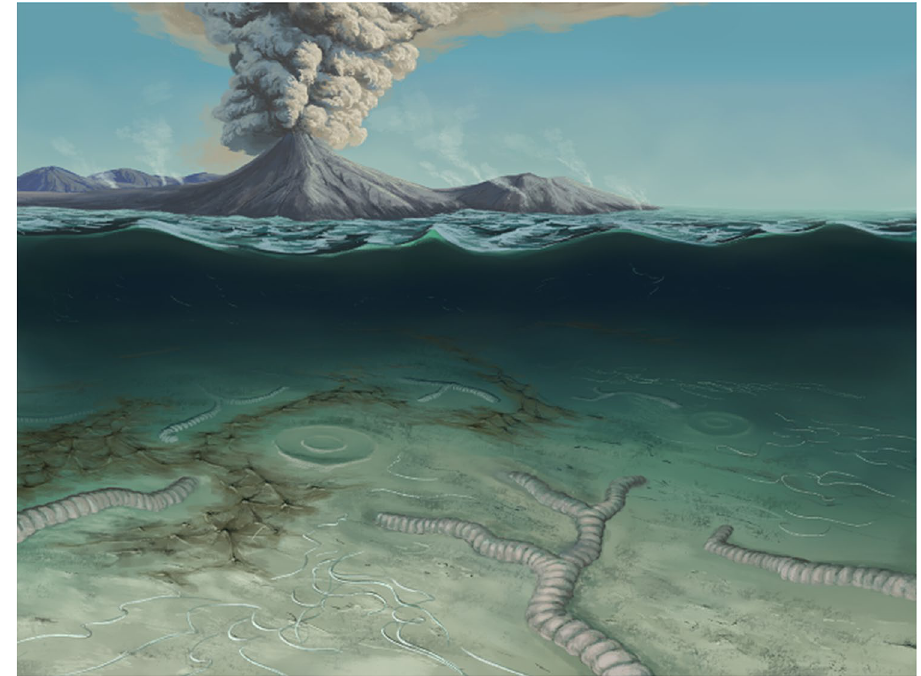
Figure 5. Artistic representation of the volcanic and microbial influences on the preservation of Itajaí organisms. Artistic reconstruction by J. S.